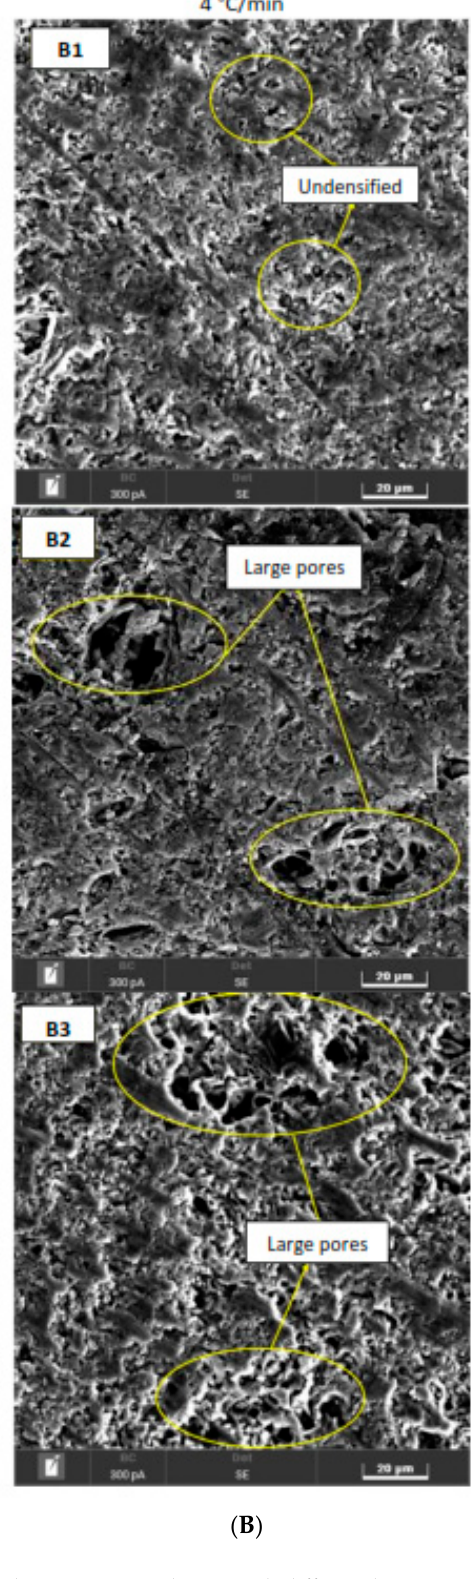
Figure 5. Microstructure of sintered kaolin-GGBS geopolymer with different heating rates (2 ◦ C/min and 4 ◦ C/min) and holding times (1 h, 2 h, and 3 h). ( A ) heating rate of 2 ◦ C/min and ( B ) Heating rate of 4 ◦ C/min.